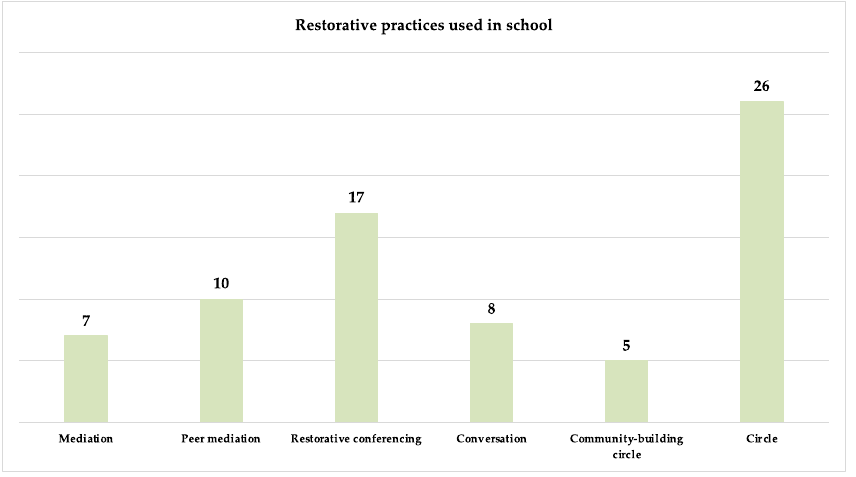
Figure 3. Restorative practices used in school.